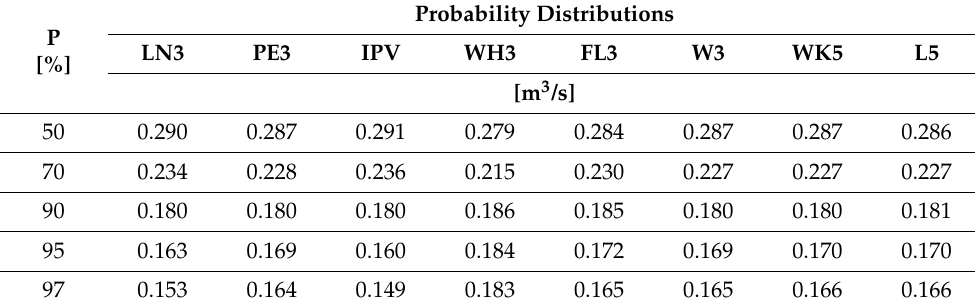
Table 8. Quantile results with